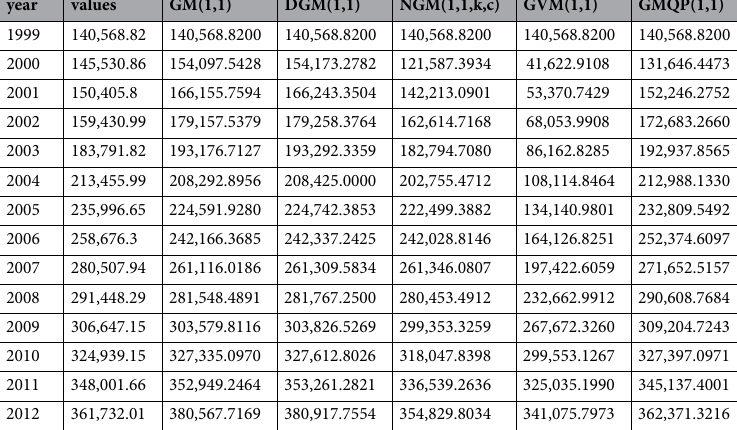
Table 2. The numerical results of the energy consumption of China (unit: 10,000